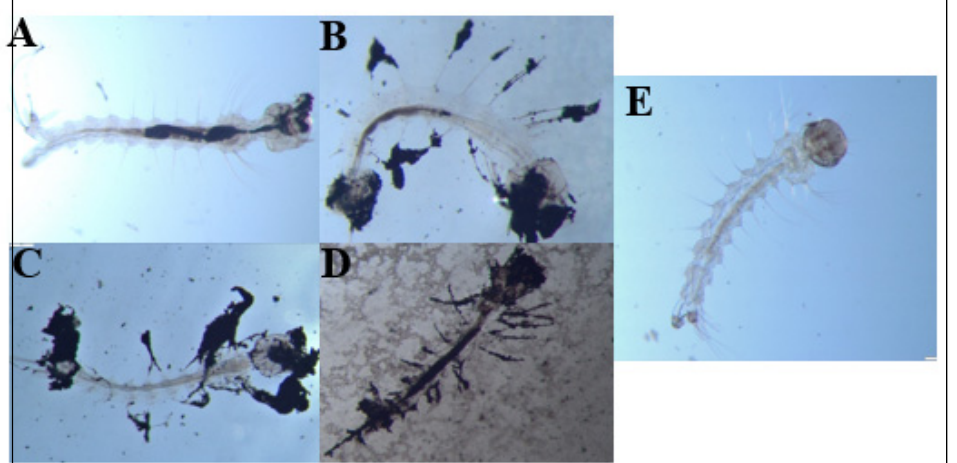
Figure 4. Dead Ae. aegypti larvae exposed to ( A ) 0.1 mg/mL or ( B – D ) 0.25 mg/mL E1800. For comparison, a control larva is shown in panel ( E ) . Accumulation of black material is observed internally (midgut, head/mouthparts) and externally (setae, anal papillae) in the larval body. Larvae were observed under an Olympus SZ6145TR Stereo Microscope at a magnification of 25× and images were captured with a GO3 Digital Color Camera.